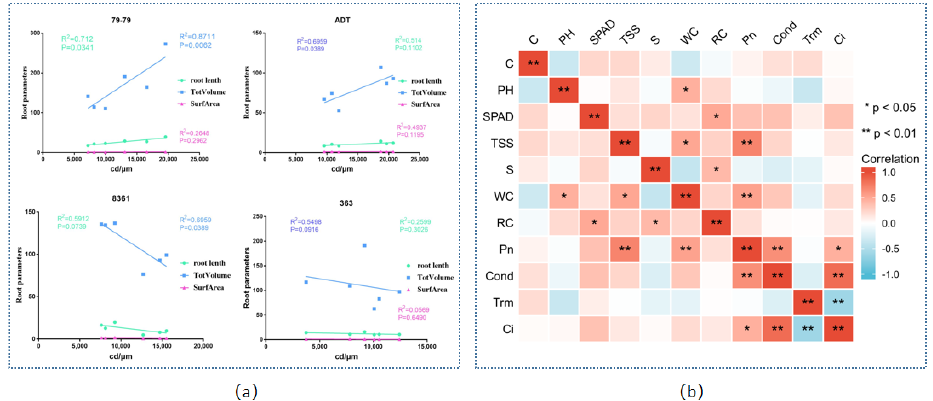
Figure 10. The correlation analysis between the cadmium content and root parameters (root length, TotVolume, SurfArea) in four different sunflower cultivars. Blue is TotVolume, green is root length, pink is SurfArea ( a ). Correlation heat − map of the Cd content, plant height, SPAD, total soluble sugar, starch, water content, relative conductivity under Cd treatment. C: content, PH: plant height, TSS: total soluble sugar, S: starch, WC: water content, RC: Relative conductivity ( b ). ** p < 0.01, * p < 0.05.